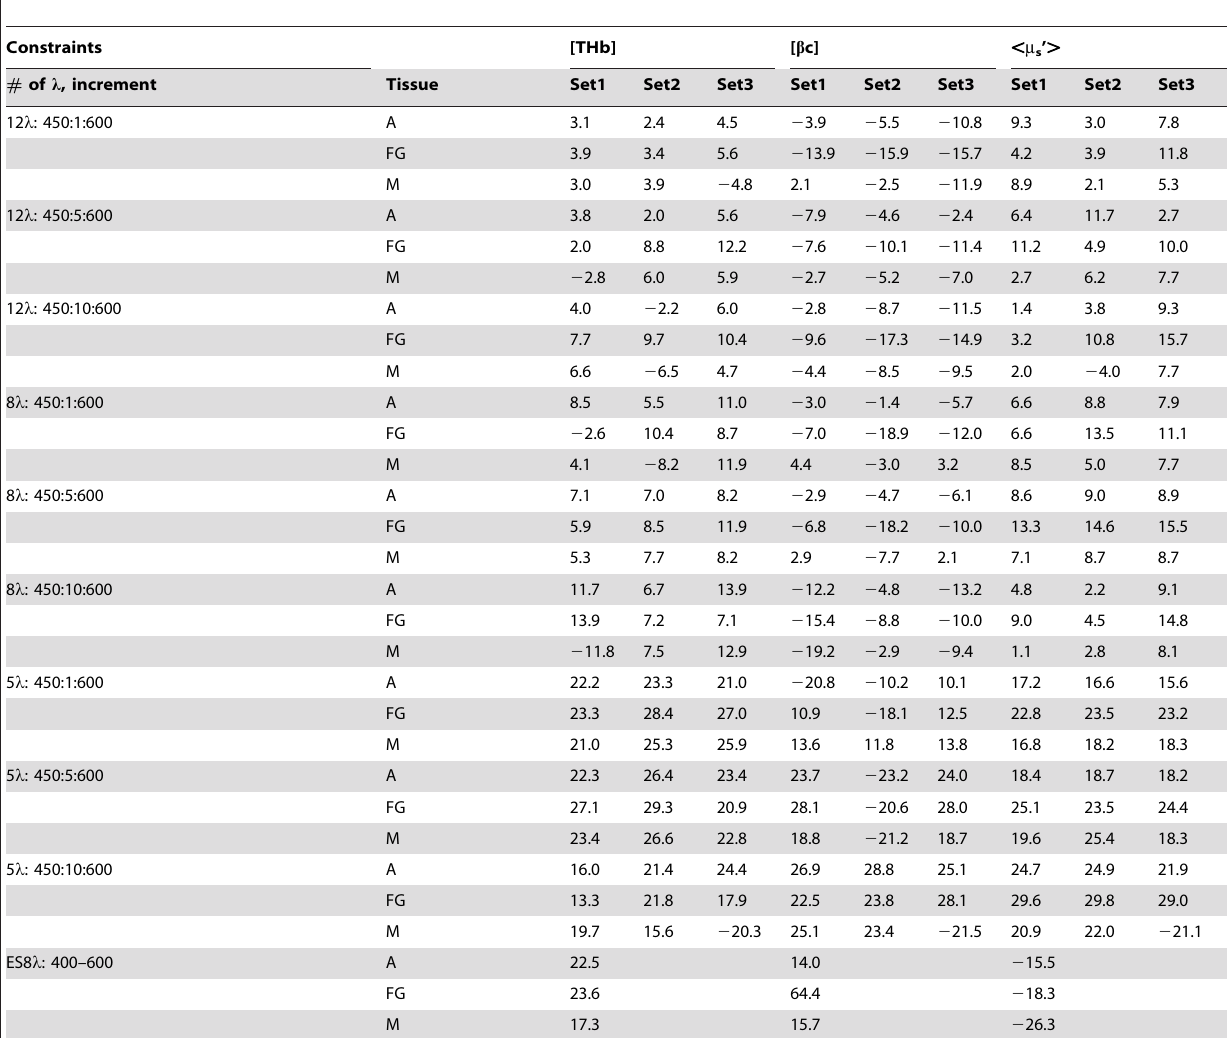
Table 4. Summary of average extracted errors of parameters for various tissue types for the top 3 optimized solutions.